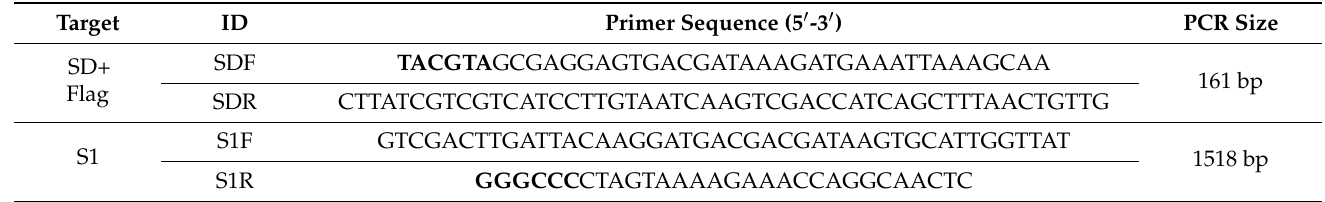
Figure 1. Schematic diagram of recombinant plasmid construction. Constitutive cell surface expression plasmid pPG-T7g10-PPT ( a ), cloning vector pMD19Ts-SD-S1 ( b ) and recombinant plasmid pPG-SD-S1 ( c ). Fusion DNA fragment SD-S1 (Lactobacillus Ribosome Binding Site sequence (SD) and PEDV S1 glycoprotein gene) obtained from pMD19Ts-SD-S1 by SnaB I and Apa I digestion was inserted into the corresponding sites of plasmid pPG-T7g10-PPT, generating recombinant plasmid pPG-SD-S1. Table 1. Details of primers used in this study.